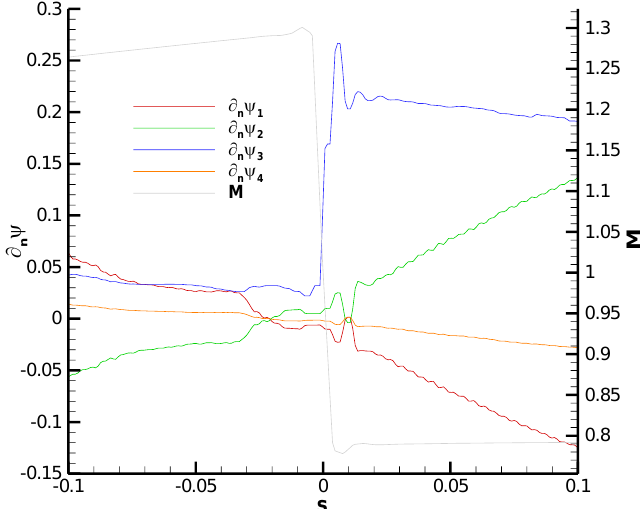
Figure 17. Flow past a NACA0012 airfoil at M = 0.8 and α = 5.794°. Adjoint normal derivatives across the shock.